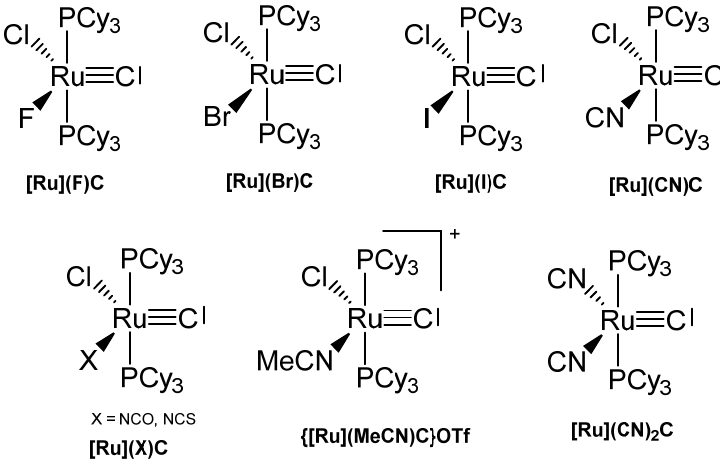
Figure 26. Carbido compounds of [Ru]XC with various